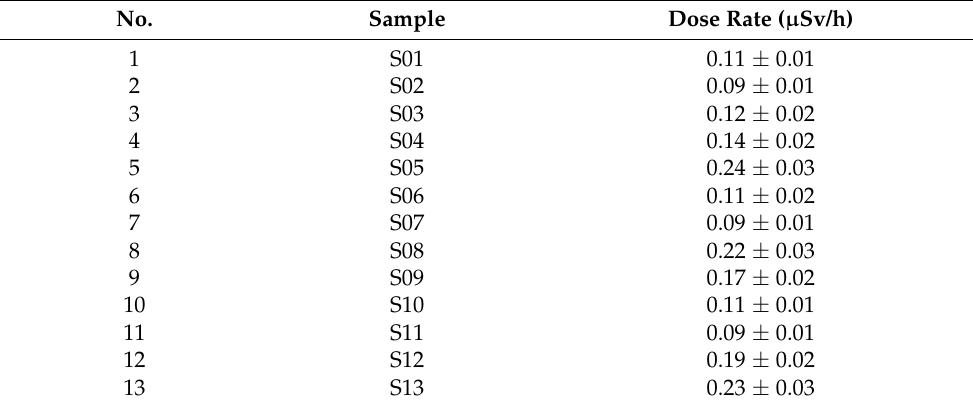
Table 4. Dose rate ( µ Sv/h) of radioactivity in the undergarments, using a Survey Meter (IdentiFinder 2) portable